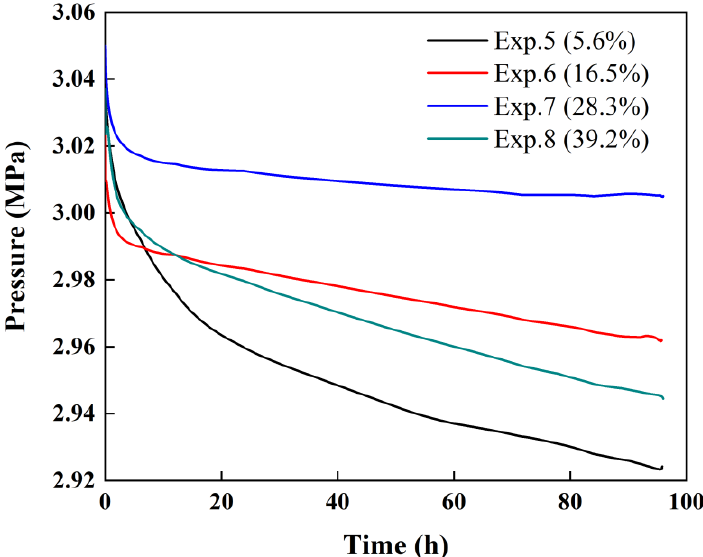
Figure 4. Variation in pressure with time during the replacement process for Experiments 5, 6, 7, and 8.